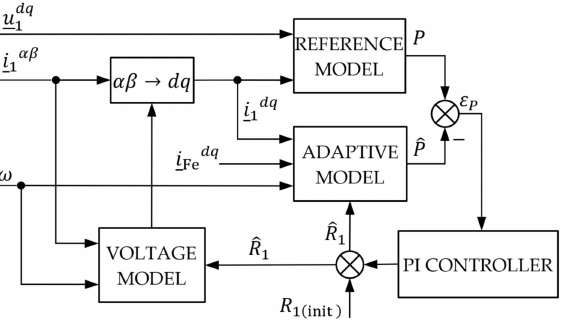
Figure 5. Modified active power MRAS for stator resistance